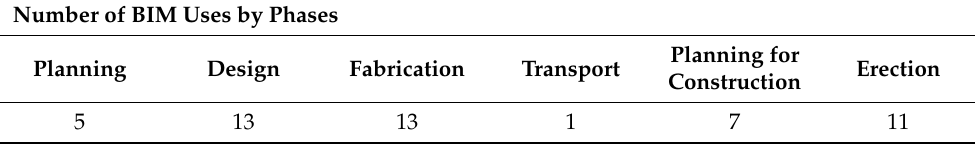
Figure 5. Cites by continent .